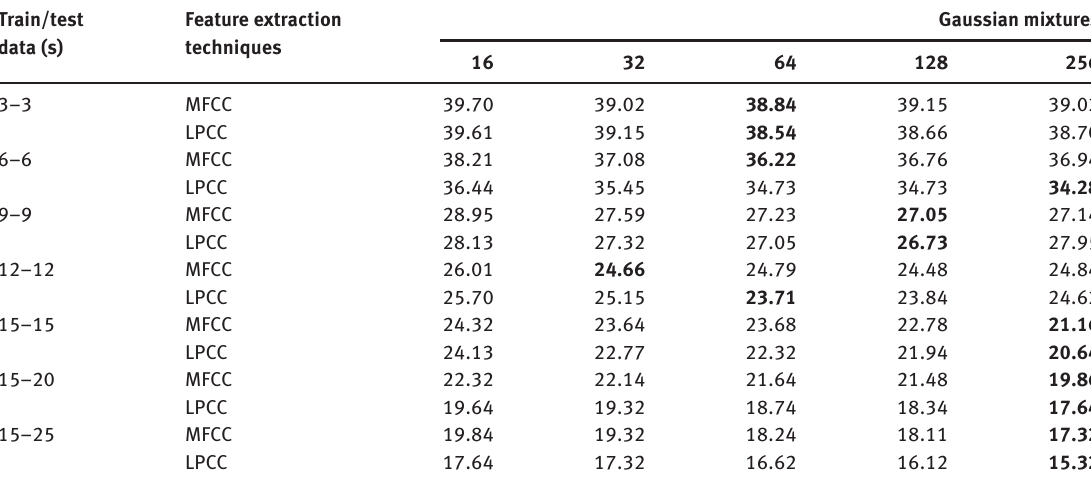
Table 6: EER of the Speaker Verification System Using MFCC and LPCC Features (39 Dimensions) and GMM–UBM Modeling for the NIST 2003 Data